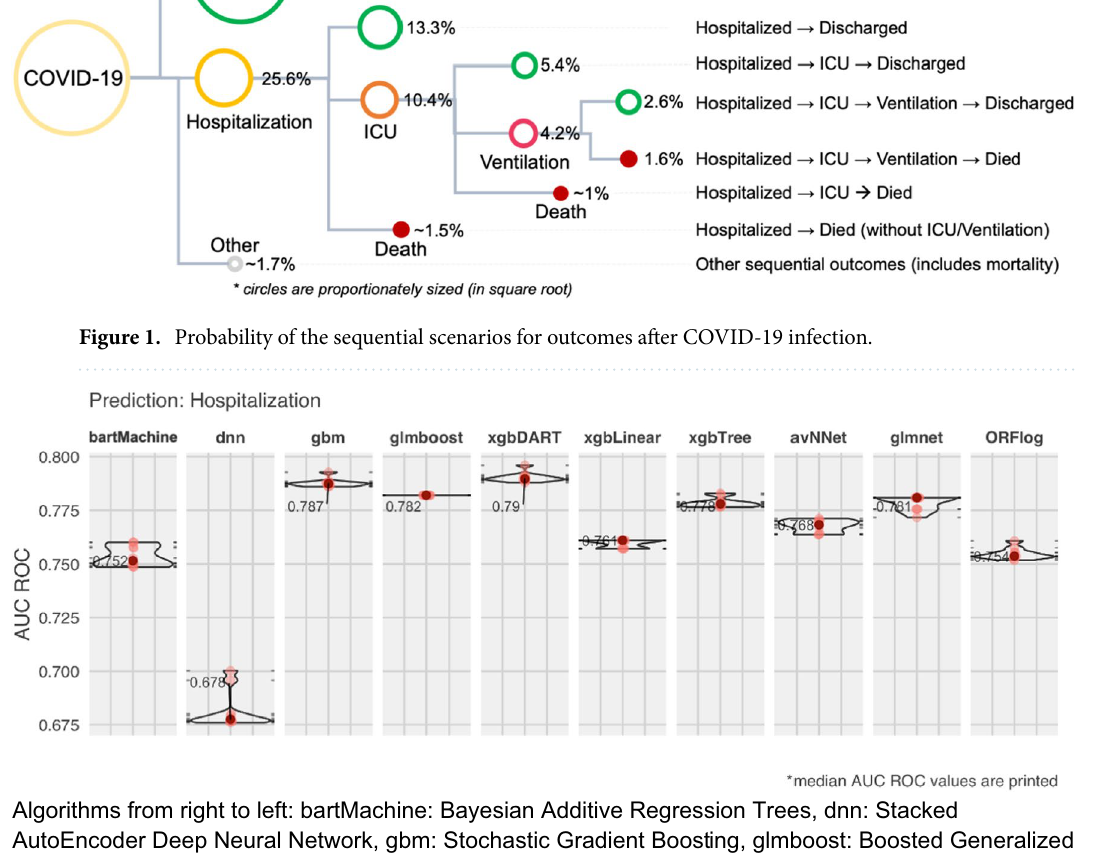
Mortality ICU Ventilation